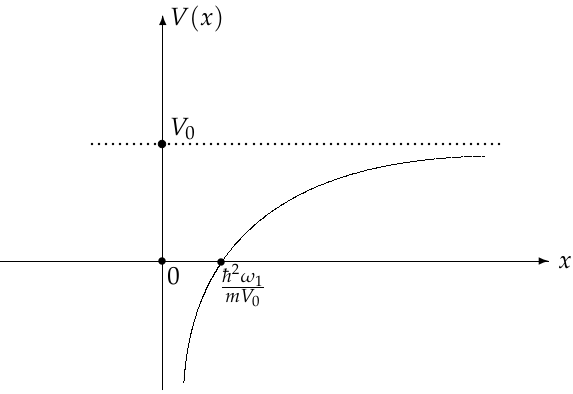
Figure 1 . The hyperbolic potential well V ( x ) Figure 1. The hyperbolic potential well V ( x )